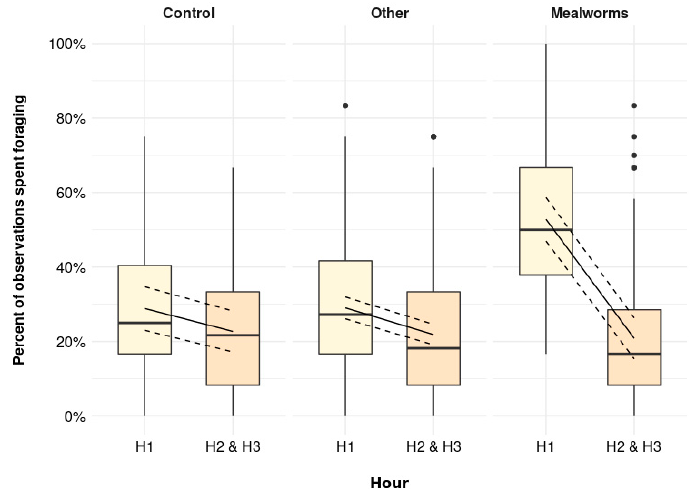
Figure 1. The percentage of observations spent foraging (including foraging active and foraging inactive) immediately after scattering was provided (H1) and later in the day (H2 and H3) for Control (no scattering), Other (scattering of shavings, whole wheat, alfalfa, or cabbage), and Mealworms ( p = 0.001). Boxplots show medians, lower, and upper interquartile range of raw data. Whiskers indicate 1.5 times the interquartile range. Solid lines represent estimated means and dashed lines represent 95 % confidence intervals.